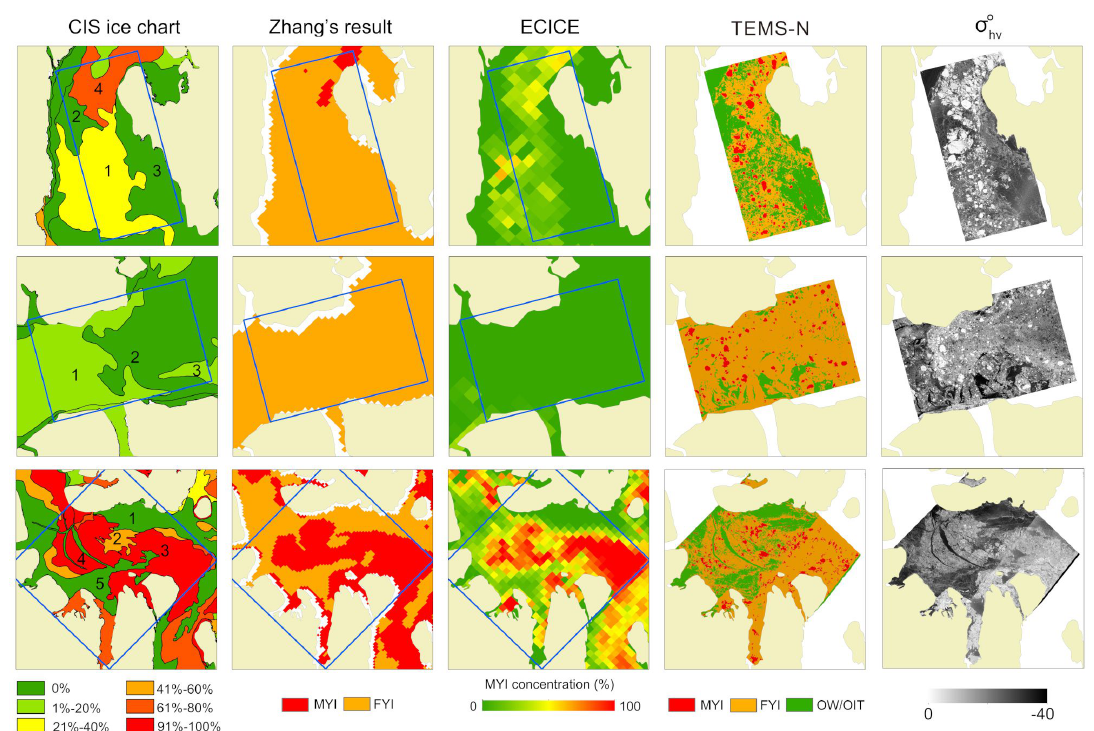
Figure 9. Comparison of TEMS-N results against other classification data in the M’Clintock Channel scene ( top ), Lancaster Sound scene ( middle ) and Viscount Melville Strait ( bottom ) scenes. In the top row CIS map is from 11 January 2016 and the rest of the maps from 16 January 2016. In the middle row the CIS map is from 21 November 2016 and the rest from 26 November 2016. In the bottom row the CIS map is from 20 March 2017 and the rest of the maps from 23 March 2017. The color of CIS chart indicates MYI concentration of the polygon. Table 5. Comparisons among the CIS chart, ECICE and the TEMS-N result in regions in some scenes.